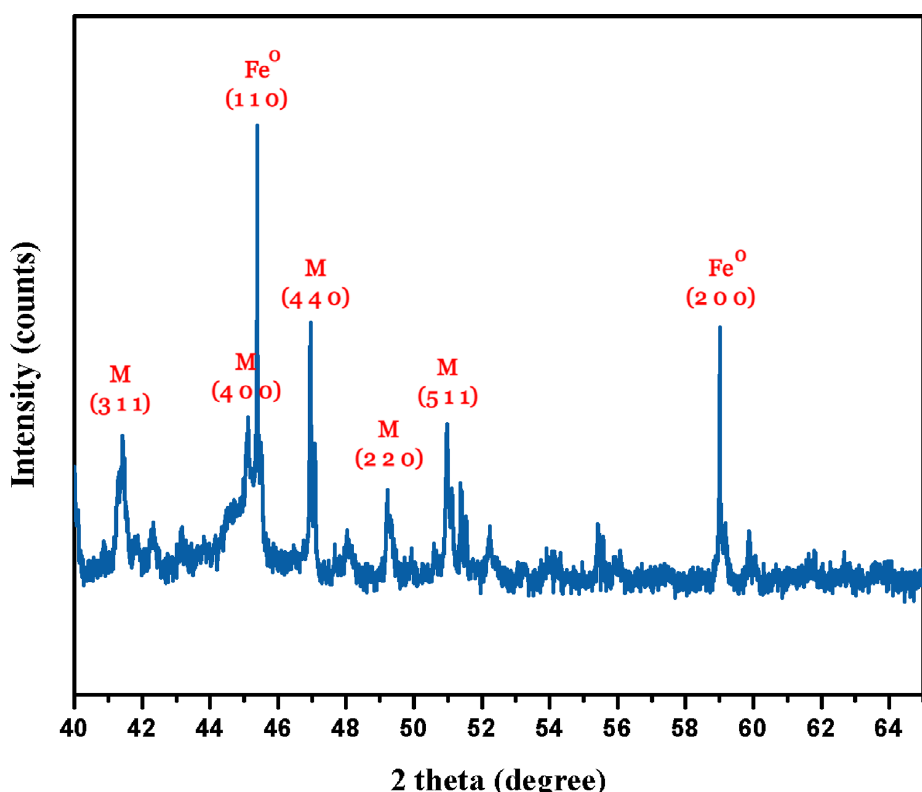
Figure 1. The XRD plot of the prepared nZVI particles [17,